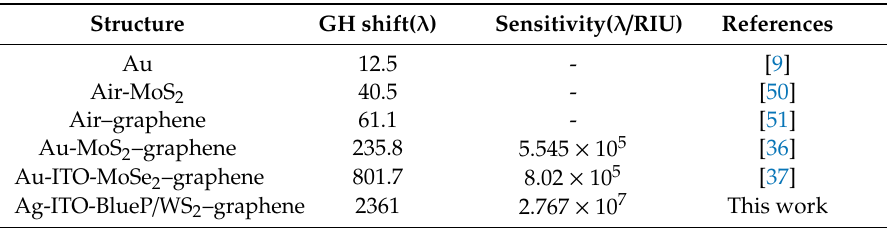
Table 7. Comparison with the previous studies GH shift and sensitivity SPR